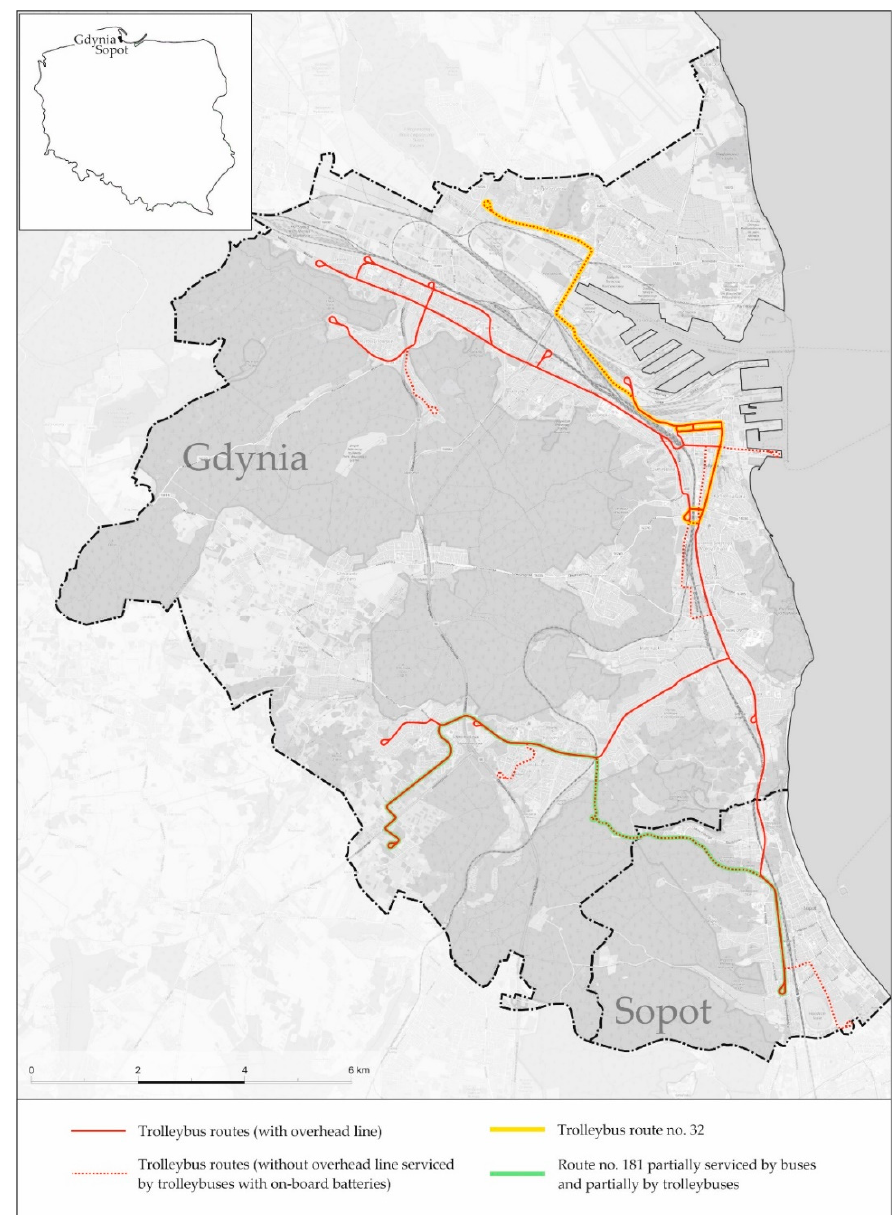
Figure 2. Connection diagram for public transport lines 32 and 181 in Gdynia and Sopot (source: Own elaboration based on OpenStreetMap).